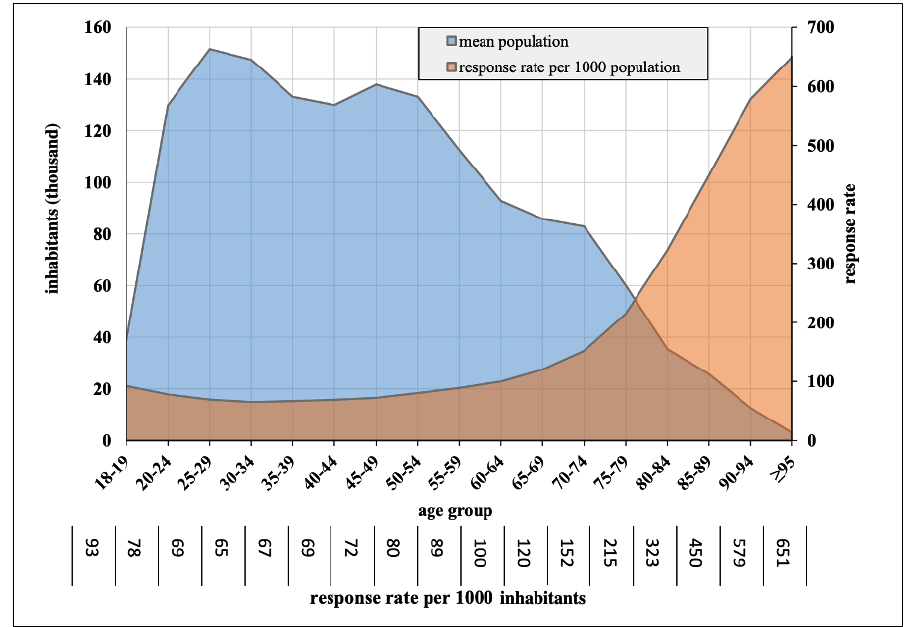
Figure 2. EMS response rates in Vienna by age group (2012-2019).